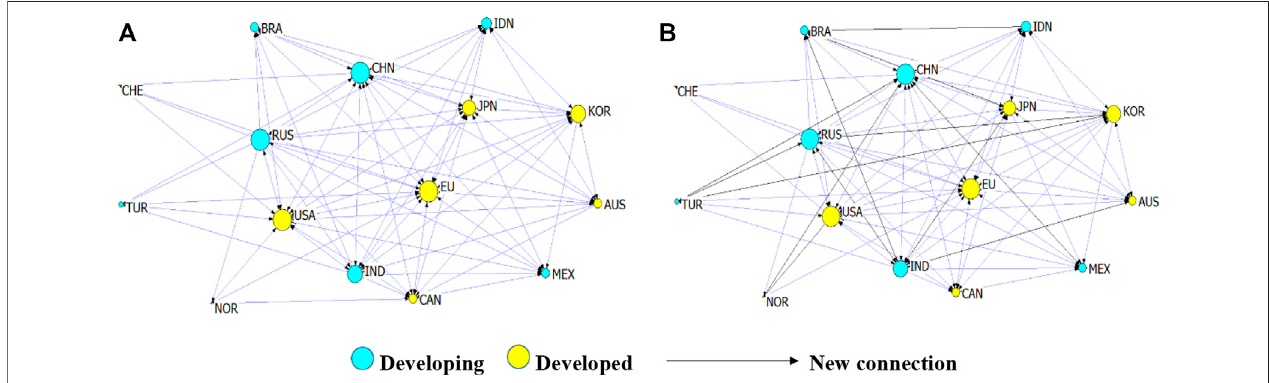
FIGURE 2 | Comparison of unweighted networks of global trade embodied carbon in 2000 and 2014. (A) Network in 2000. (B) Network in 2014.